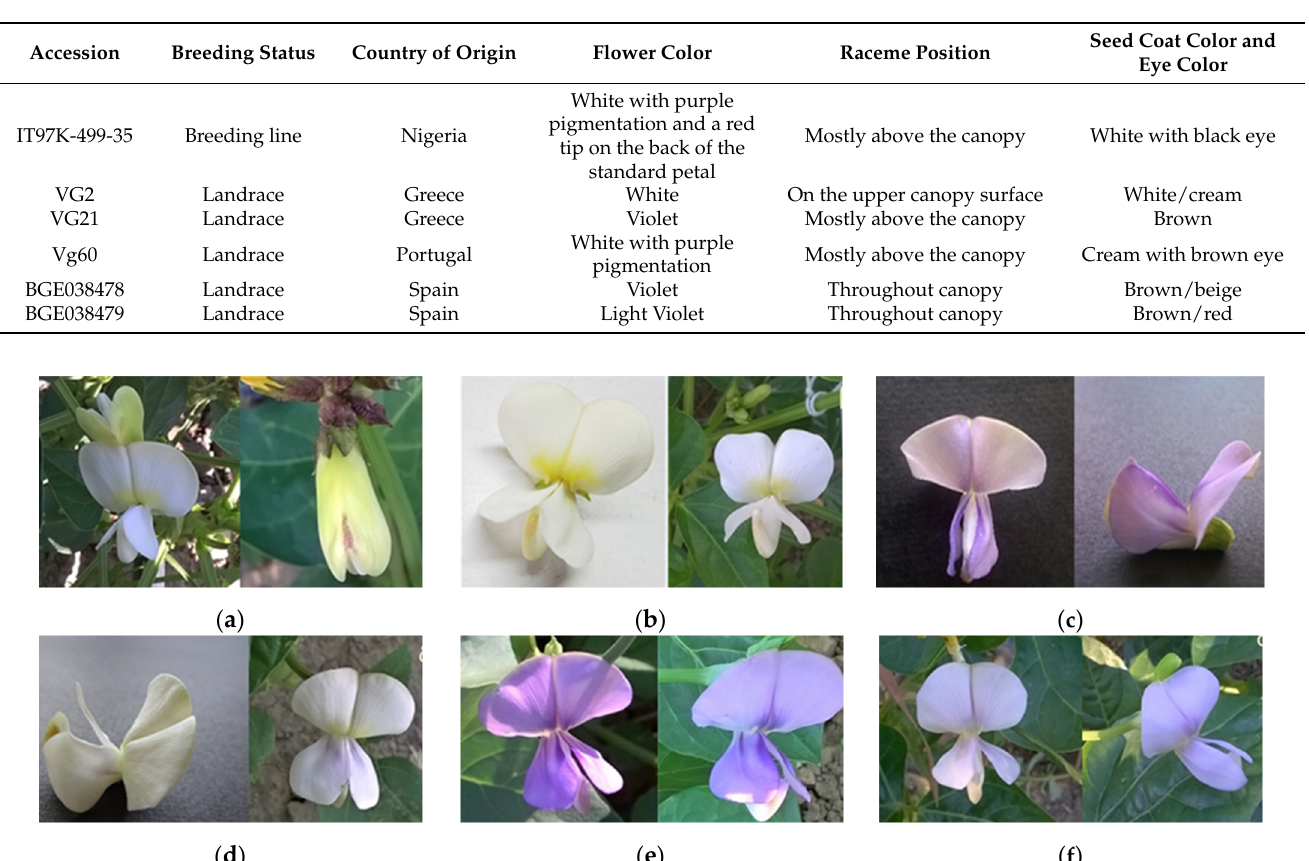
Table 1. Cowpea accessions, breeding status, origin, flower color, raceme position, seed coat color, and eye color.